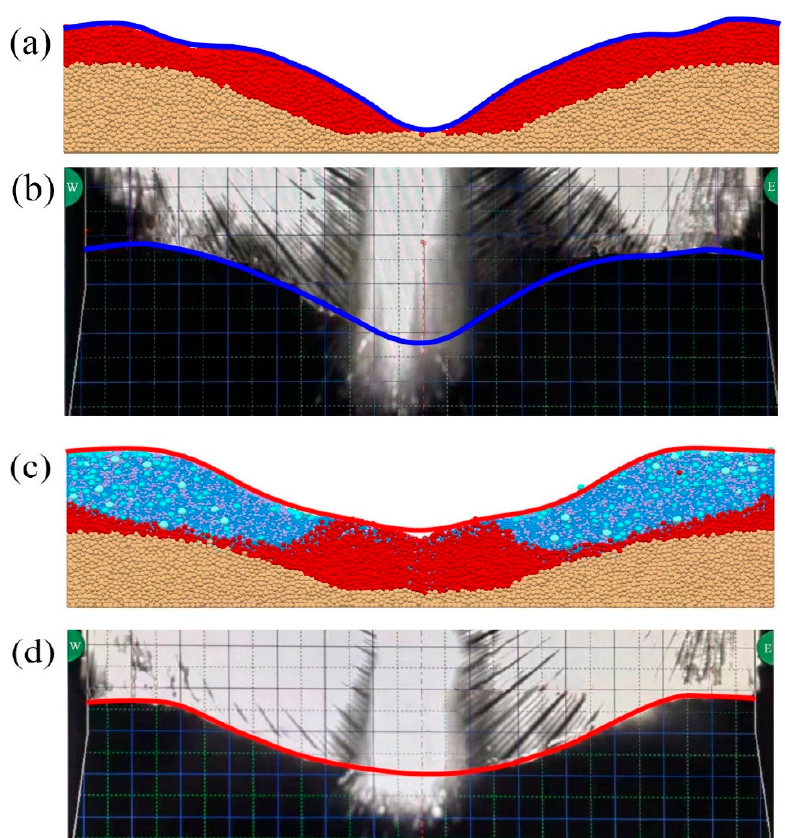
Figure 5. Coke burden surface and ore burden surface under base conditions: ( a ) coke simulated burden surface; ( b ) coke measured burden surface; ( c ) ore simulated burden surface; ( d ) ore measured burden surface.